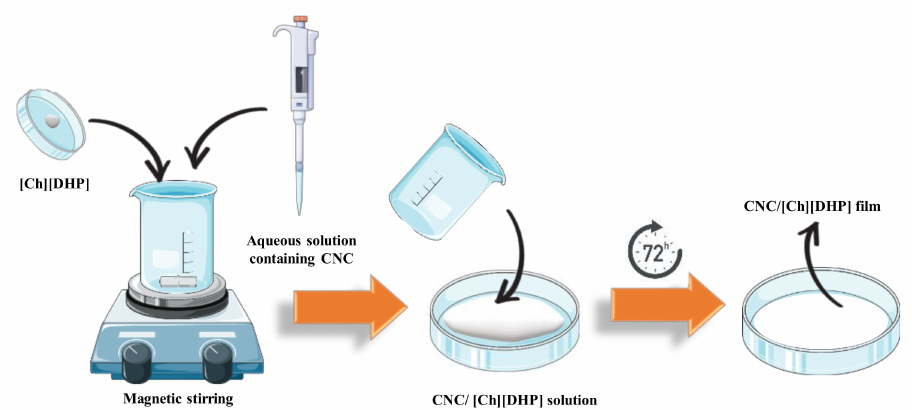
Figure 1. Schematic representation of cellulose-derivatives / [Ch][DHP] composite films prepared by solvent evaporation